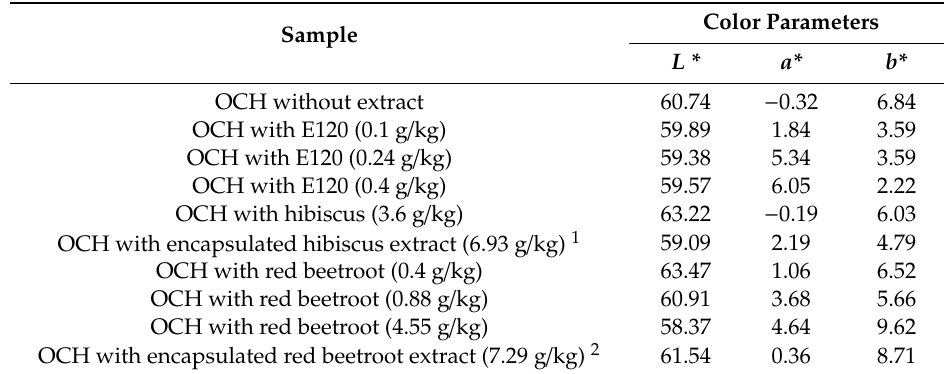
Table 2. Colorimetric data ( L* , brightness; a* , green vs. red coordinate; and b* , blue vs. yellow coordinate) of ordinary cooked ham (OCH) samples prepared without dye and with E120, and extracts of hibiscus and red beetroot.